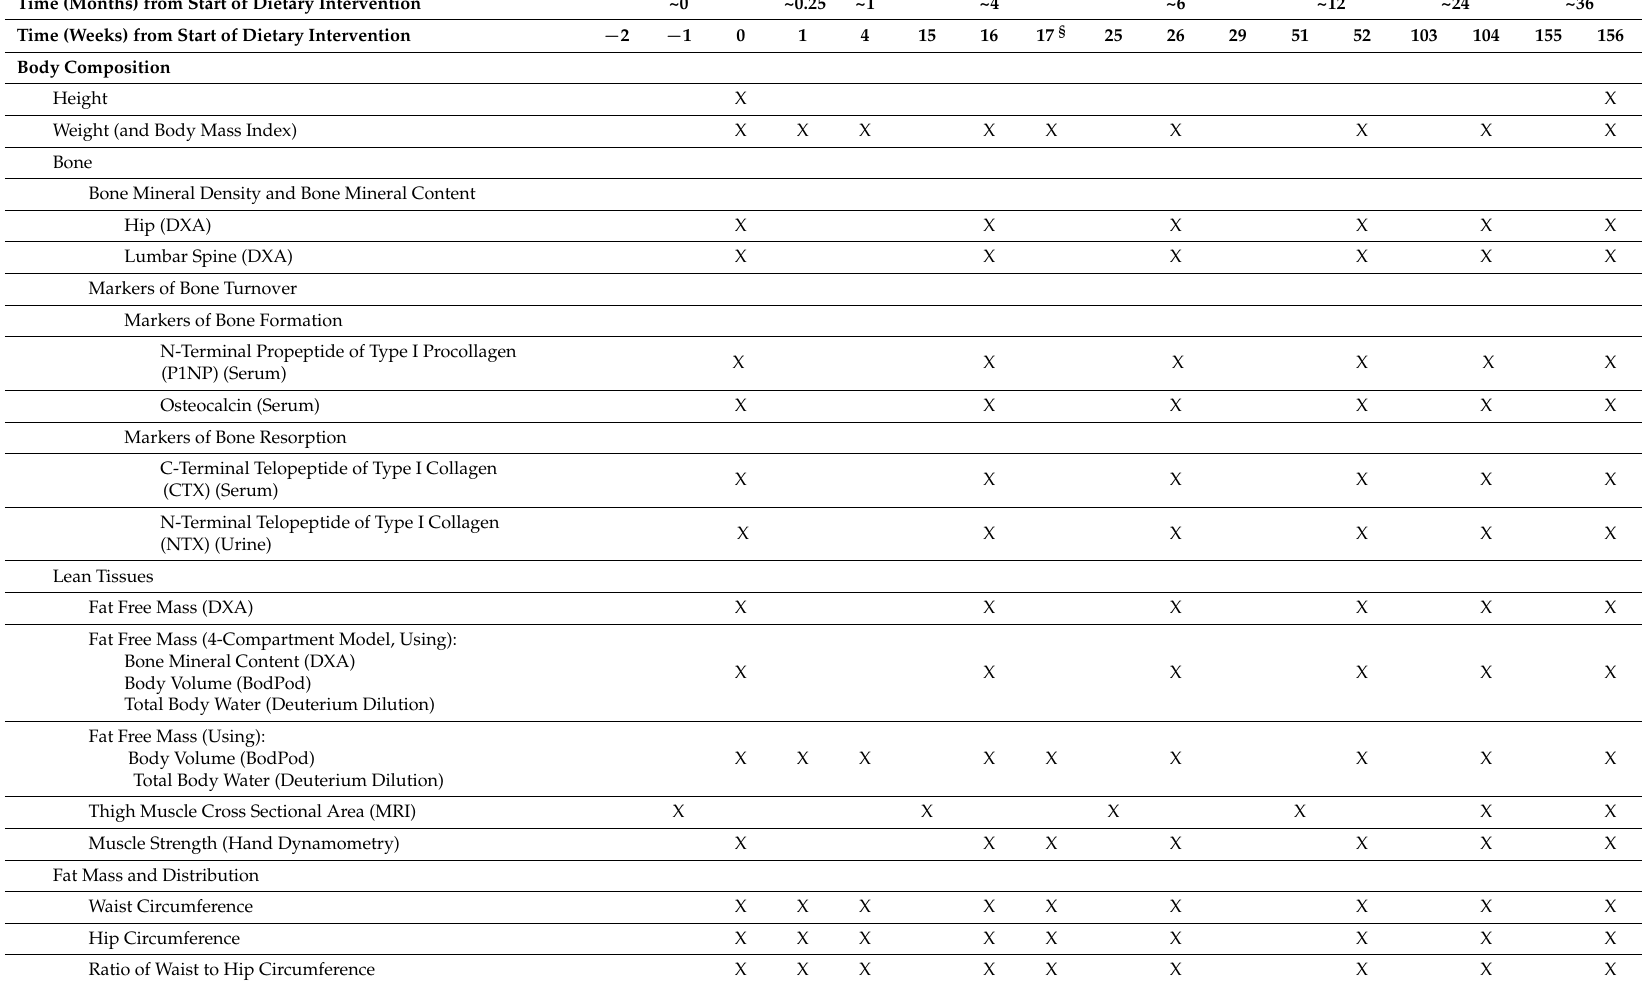
Table 2. Outcomes measured at each time point during the TEMPO Diet